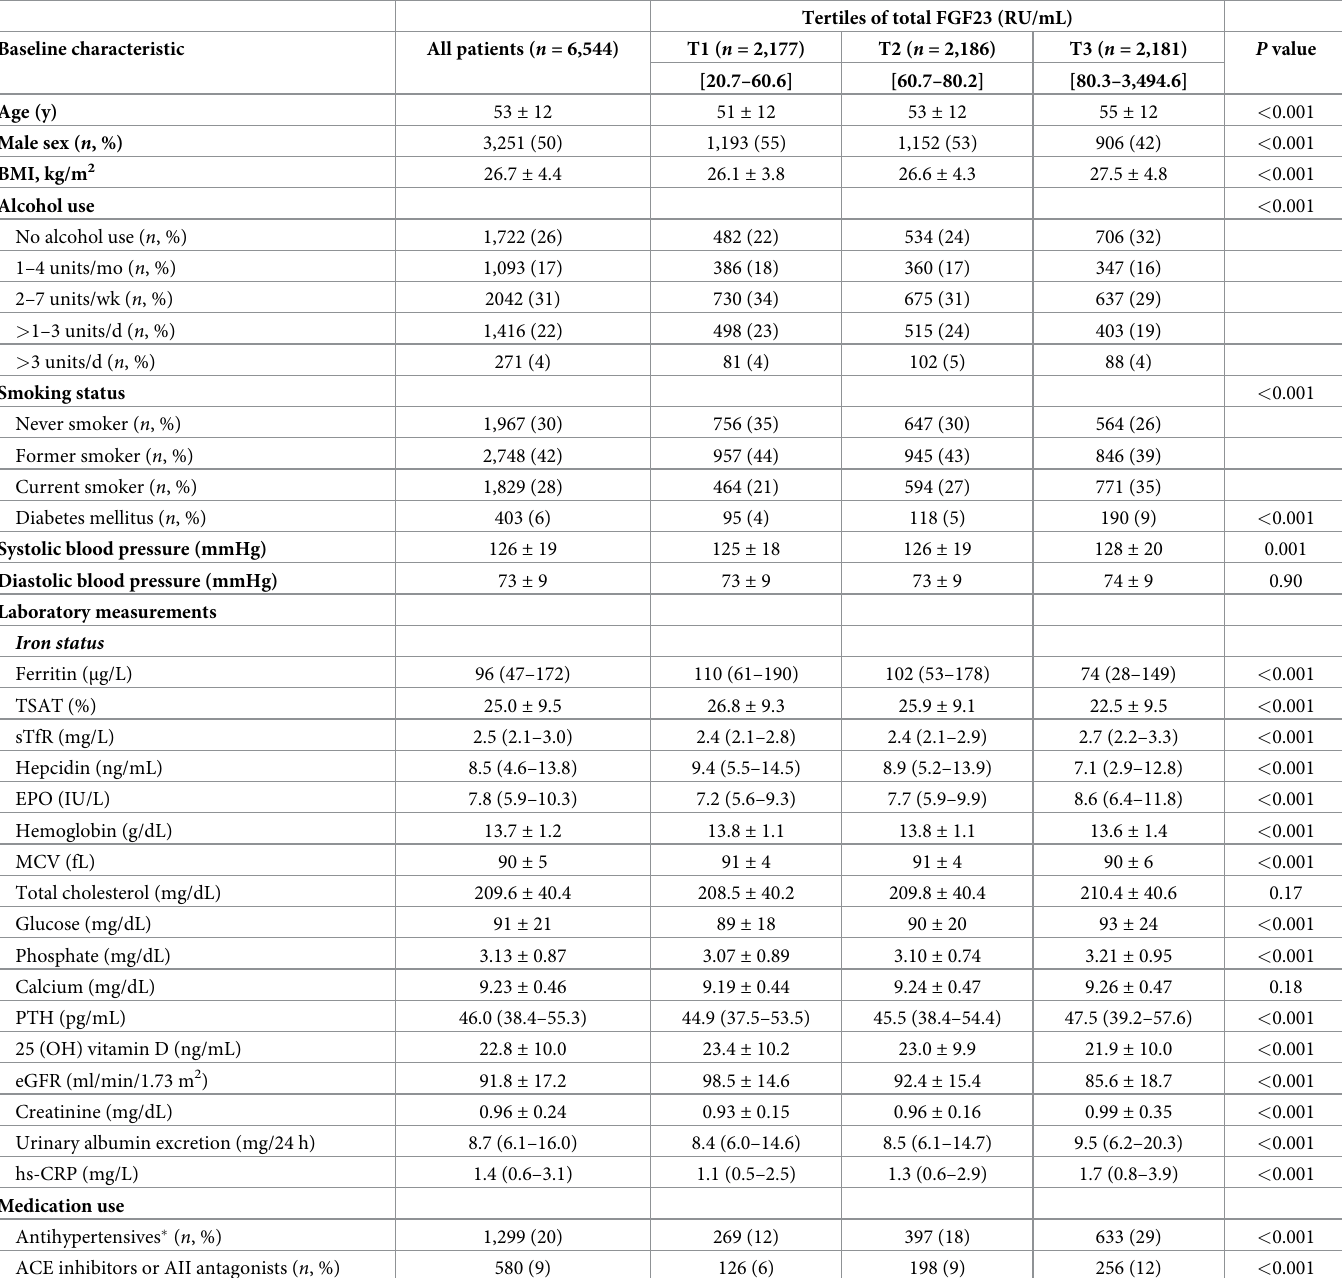
Table 1. Baseline characteristics of 6,544 community-dwelling subjects according to tertiles of total FGF23 levels.